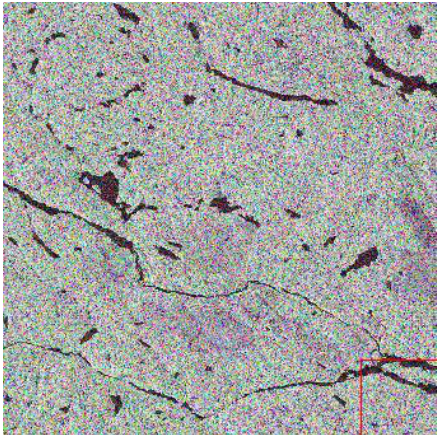
Figure 1 Radarsat-2 polarimetric SAR data of PRF, Ontario